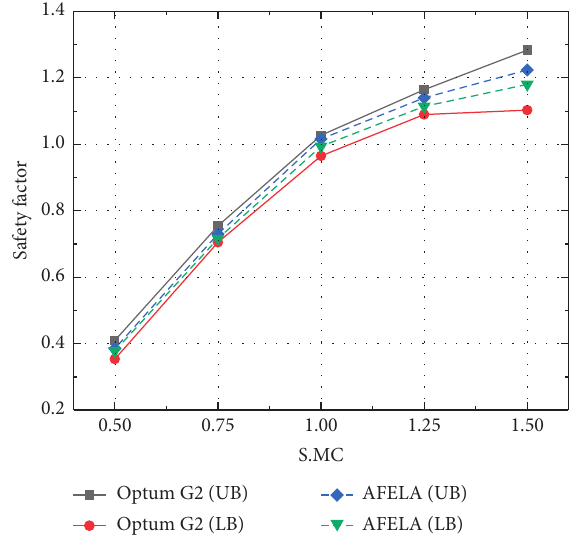
Figure 4: Comparison of calculation results of slope safety factor.